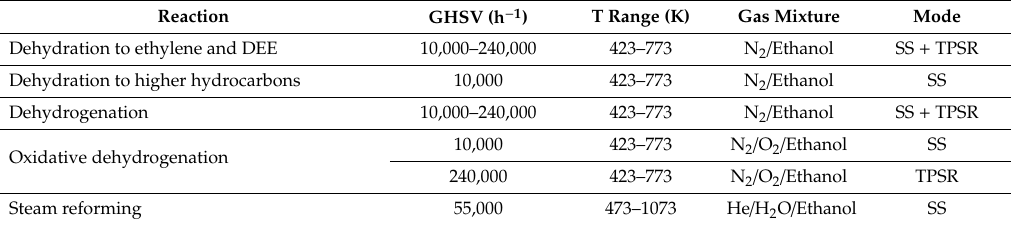
Table 1. Experimental conditions applied in the catalytic tests (SS = steady state; TPSR = temperature – programmed surface